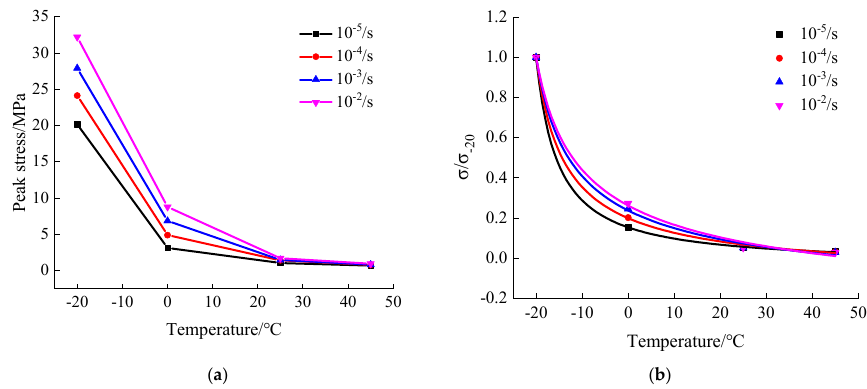
Figure 7. Relation between temperature and peak stress of hydraulic asphalt concrete. ( a ) peak stress; ( b ) variation coefficient.